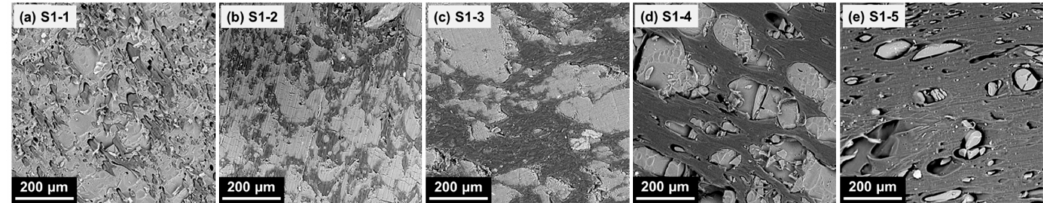
Figure 1. SEM micrographs of the cross sections of the injection moulded test specimens of the compounds produced in Series 1. Bright areas indicate novolac-based phase, dark areas indicate LDPE. LDPE content increases from left to right: 20 m%, 30 m%, 40 m%,50 m%, 70 m%.